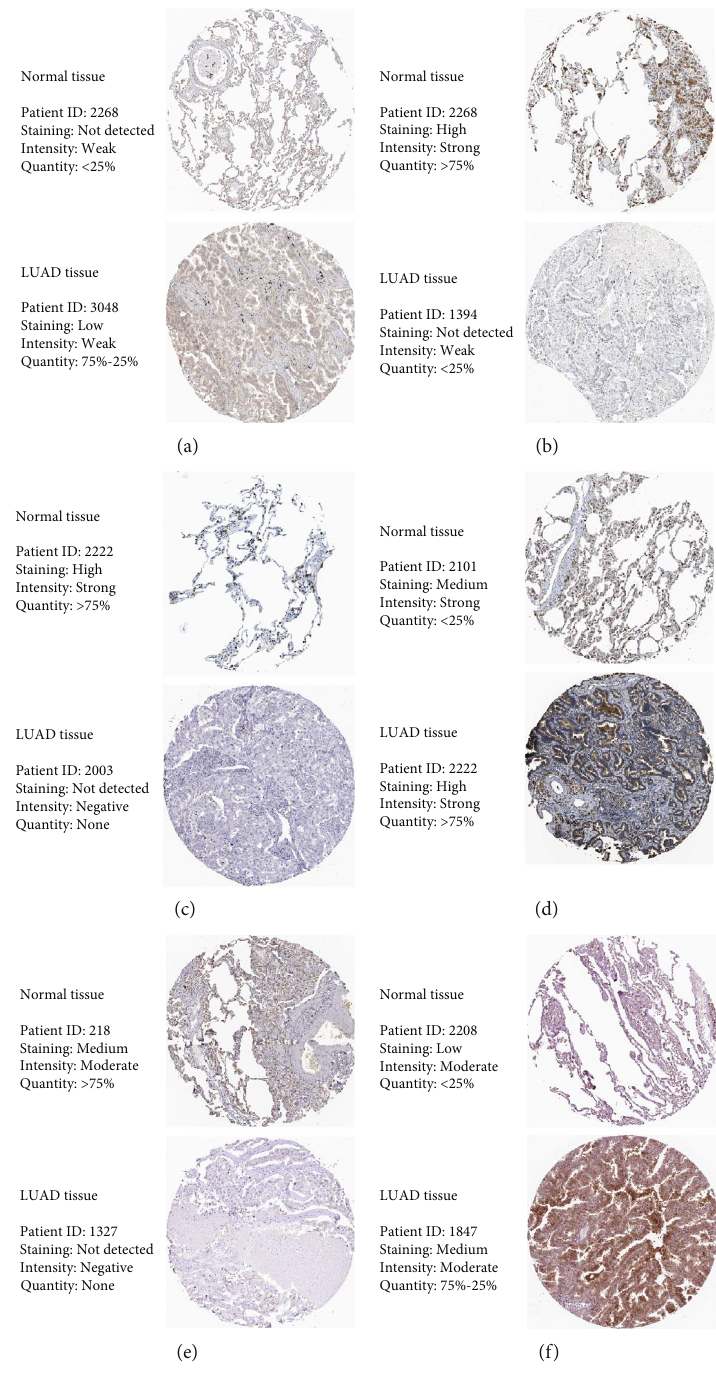
Figure 8: Validation of signature genes with immunohistochemistry. (a) ABCD1. (b) ACAT1. (c) ACSL1. (d) ACSL3. (e) CAT. (f)